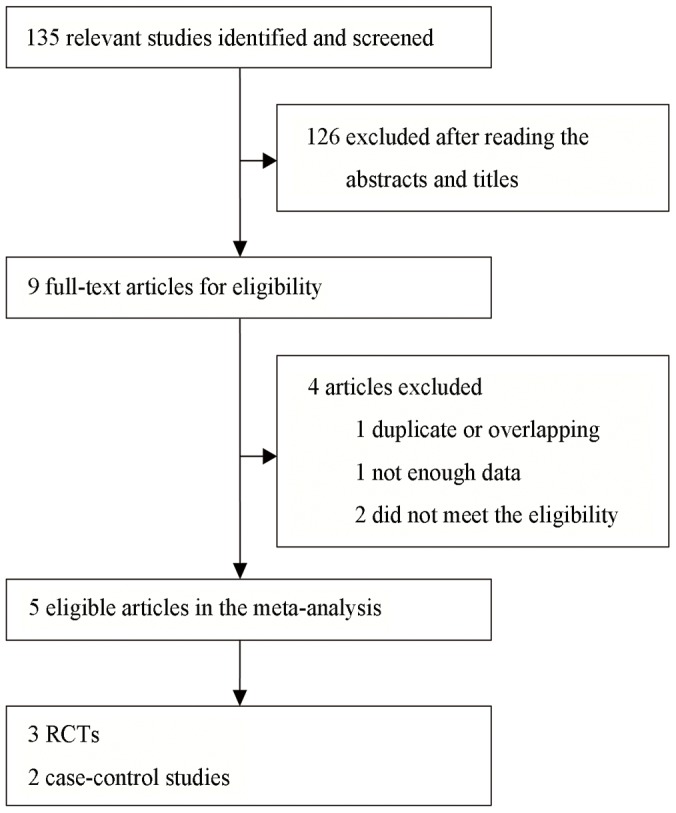
Search strategy.